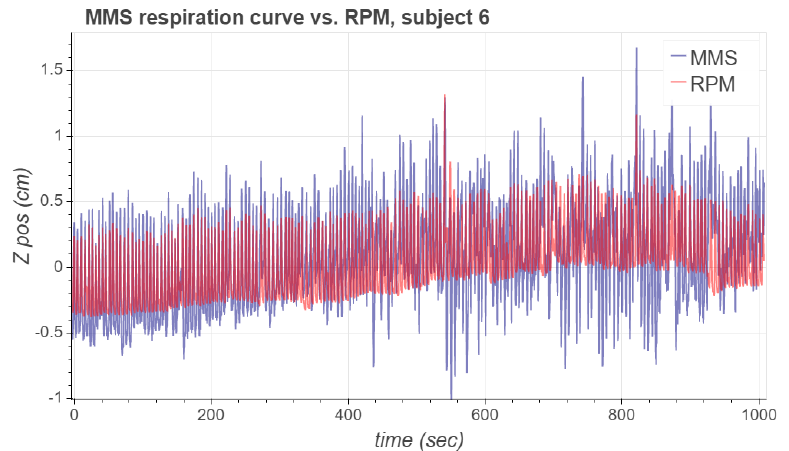
Figure 9. MMS vs. RPM respiratory waveforms for subject 6. The MMS signal quality deteriorates significantly in the second half of the measurement due to poor attachment of the sensor